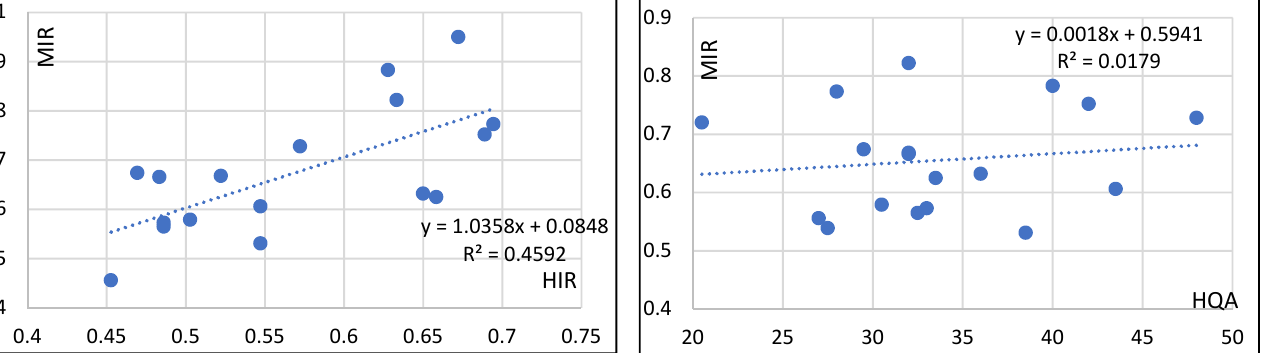
Figure 5. Correlation between HIR and MIR as HQA and MIR.